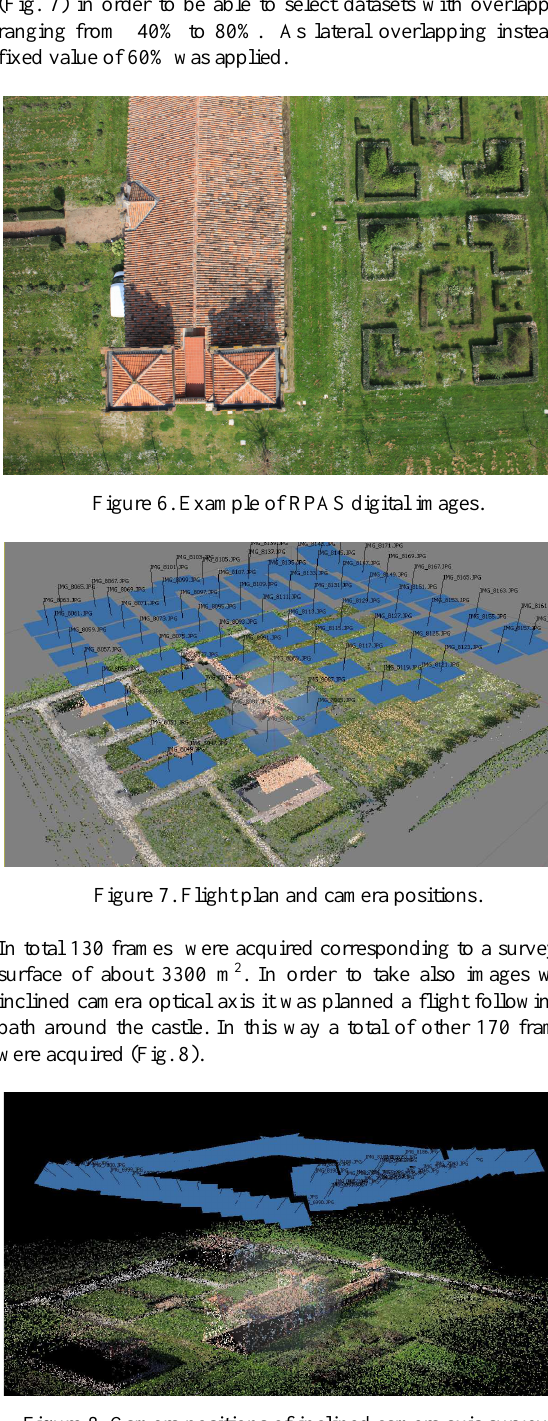
Figure 8. Camera positions of inclined camera axis survey.